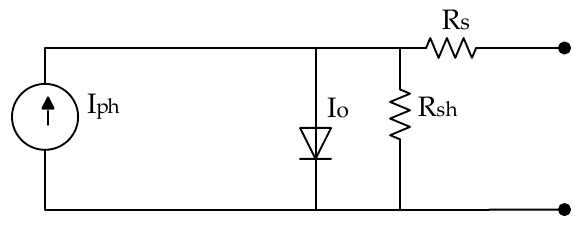
Figure 1. The equivalent circuit of PV cell.